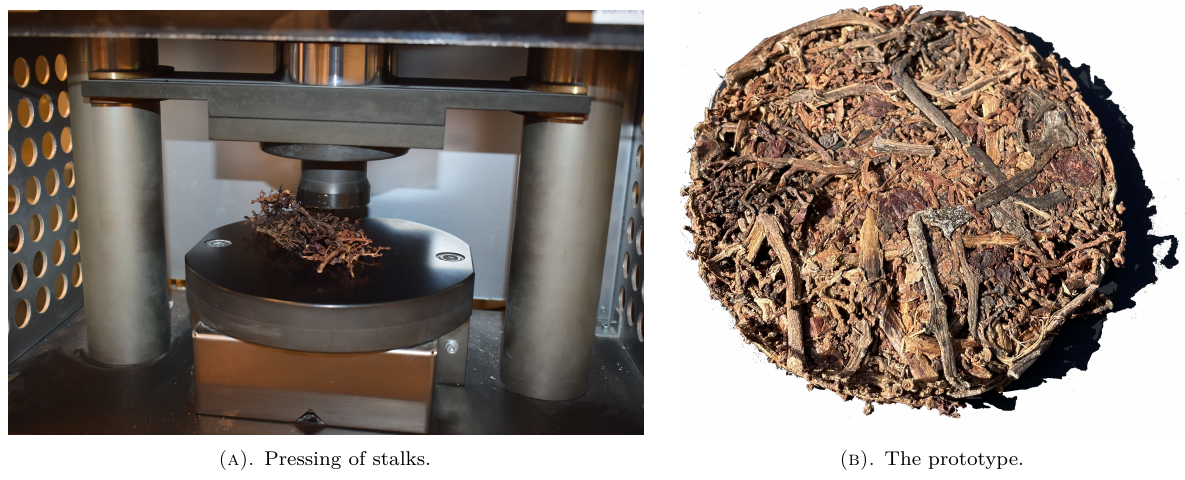
Figure 5. Experimental phase: the sample includes the raw by-product without the addition of adhesives or binding